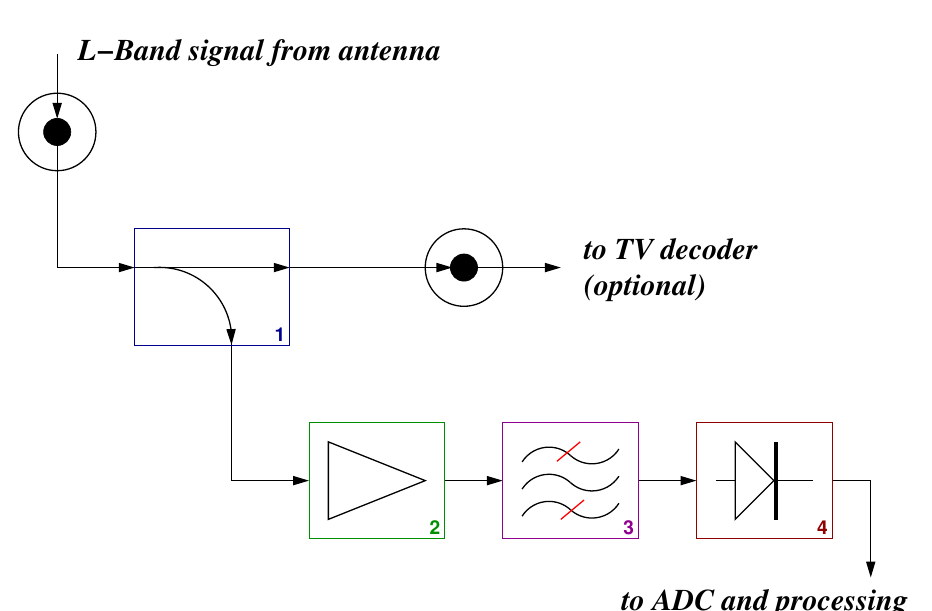
Figure 2. Schematic diagram of the RF front-end of a Smart Rainfall System (SRS)